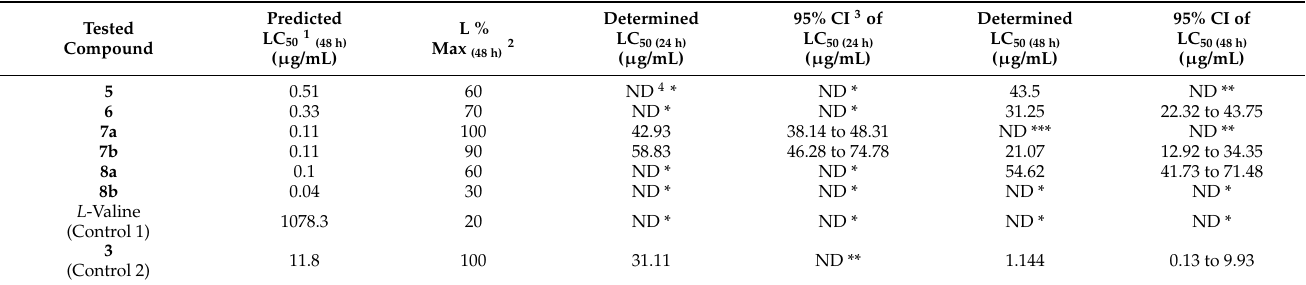
Table 9. Daphnia magna toxicity test results.